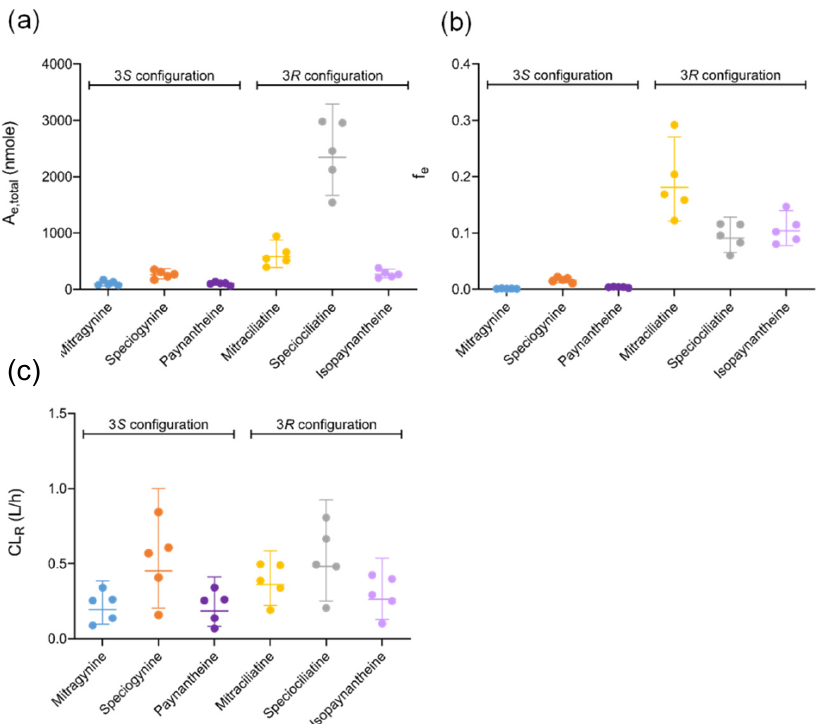
Figure 5. ( a ) Total amount of kratom alkaloids excreted in urine (A e,total ) after kratom tea administration over a 120 h collection period. ( b ) Fraction of the administered dose excreted unchanged in the urine (f e ) from 0–120 h. ( c ) Renal clearance (CL R ) of kratom alkaloids. Symbols denote individual data points for the five participants who completed the study. Horizontal lines denote geometric means. Error bars denote 95% confidence intervals.